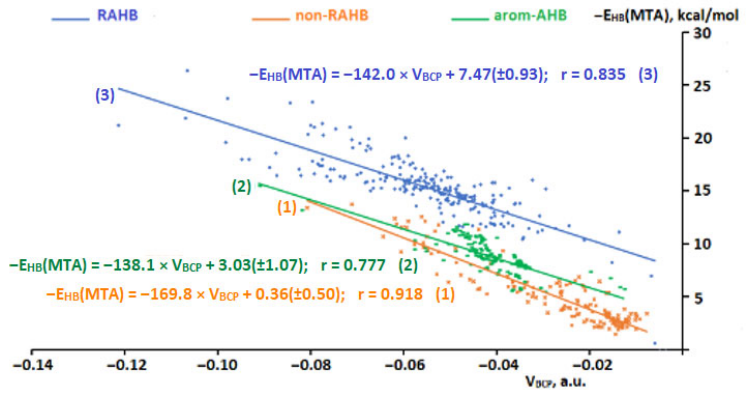
Figure 2. Dependence of the − E HB (MTA) energy for the non-RAHB, RAHB, and arom-AHB clusters on the V BCP values.